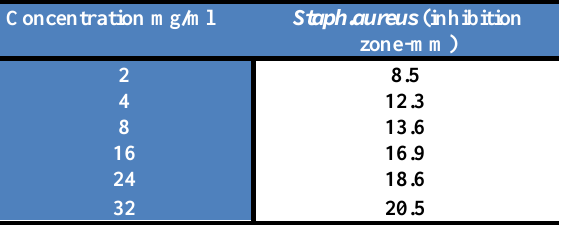
Table, 2: Antibacterial activity of D.innoxia extract at different concentrations on growth of S.aureus (agar well